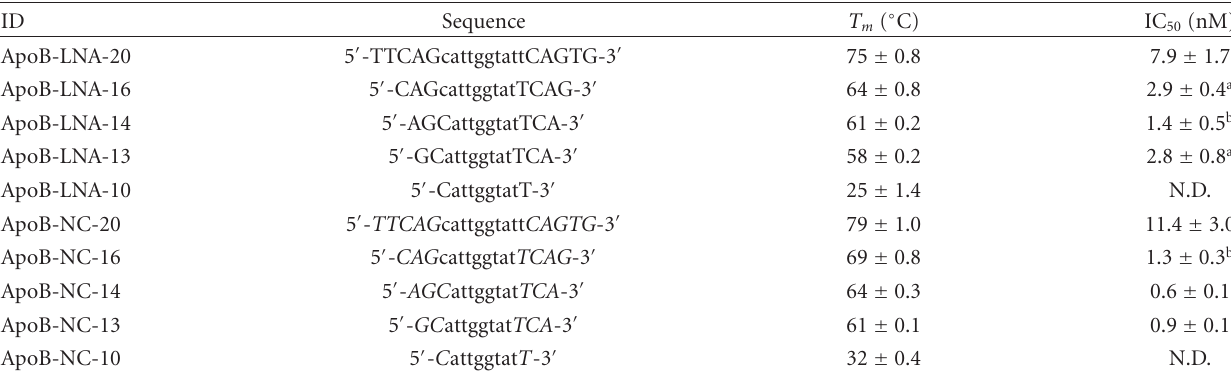
Table 1: Oligonucleotides used in this